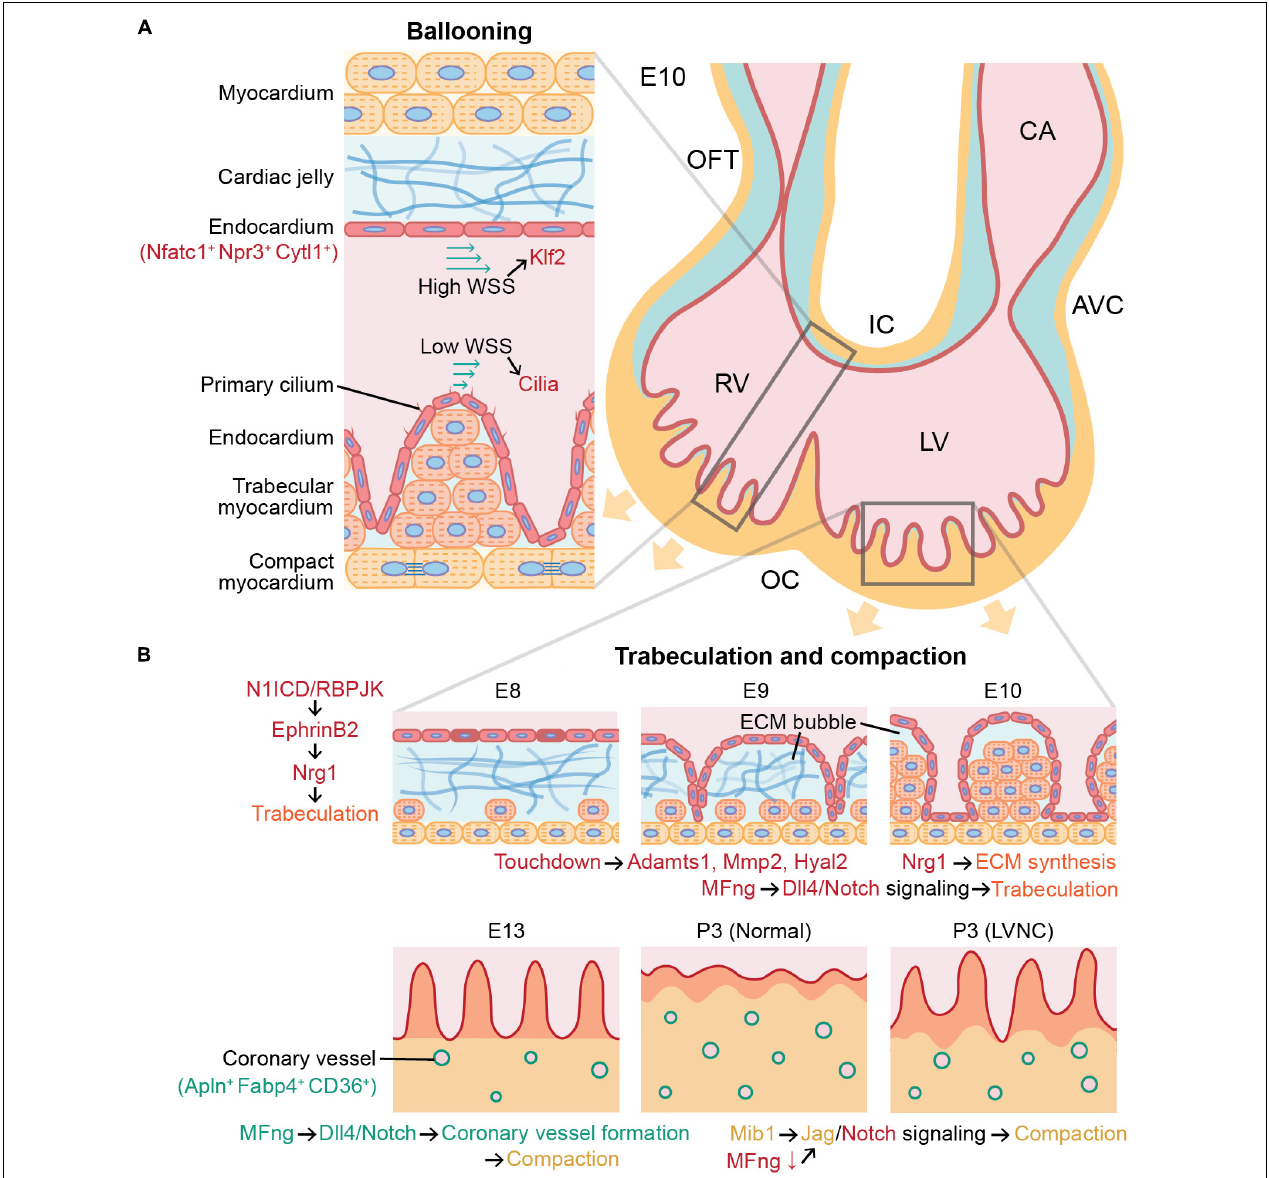
FIGURE 1 | Role of angiocrine signaling in cardiac chamber ballooning, trabeculation, and compaction during cardiac development. Angiocrine signaling of cardiac endothelial cells governs major cellular and molecular processes in mammalian heart development. (A) Ballooning is achieved by more active proliferation in the outer curvature (OC) than in the inner curvature (IC), and this asymmetric proliferation between the inner and outer curvatures is associated with Klf2 and cilia signaling in endocardial cells activated by wall shear stress (WSS). (B) Initiation of trabeculation and growth of trabeculae (orange) in ECM bubble are regulated by Nrg1 secreted by endocardial cells (red). After trabeculation, compaction requires angiocrine signaling in both coronary endothelial cells (green) and endocardial cells (red). Endothelial dysfunction can cause left ventricular noncompaction (LVNC). Trabecular and compact cardiomyocytes are indicated in orange and yellow, respectively. E10, mouse embryonic day 10; OFT, outflow tract; RV, right ventricle; LV, left ventricle; CA, common atrium; AVC, atrioventricular canal; ECM, extracellular matrix; and P3, postnatal day